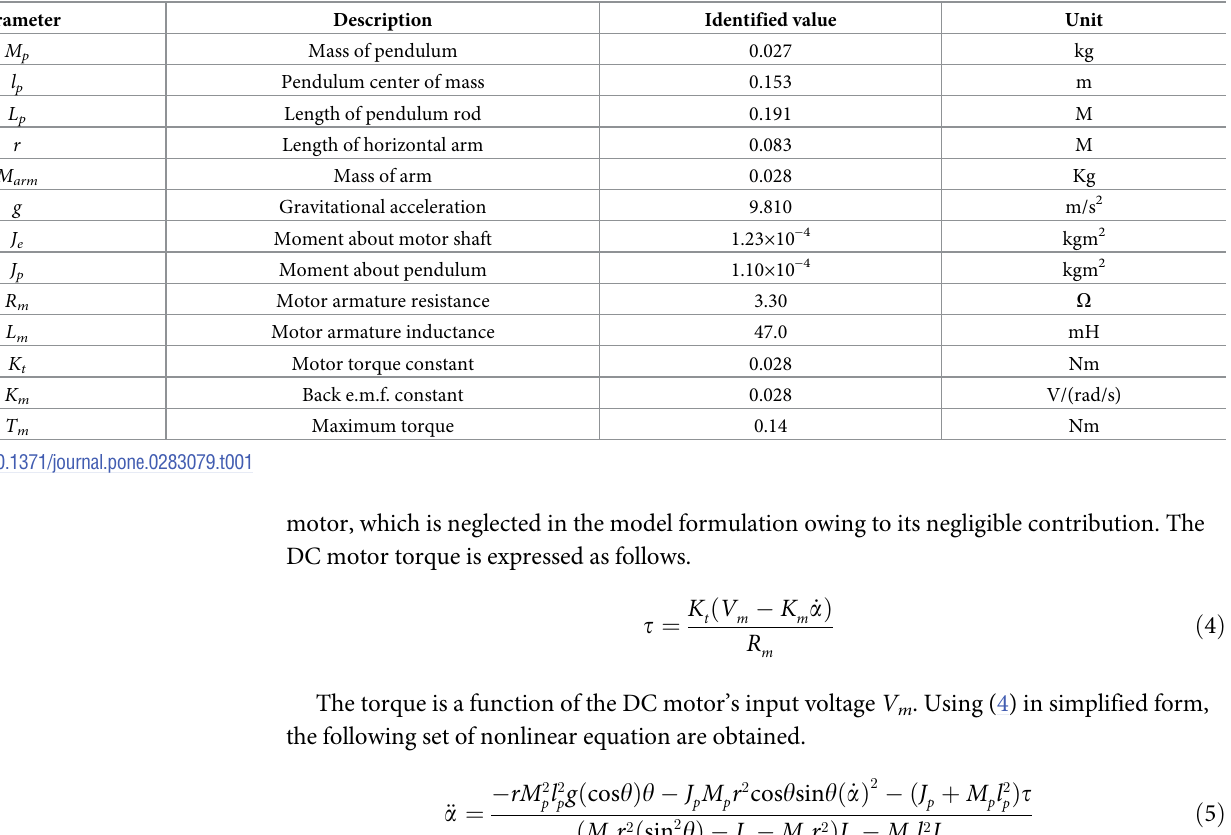
Table 1. Model parameters of QNET rotary